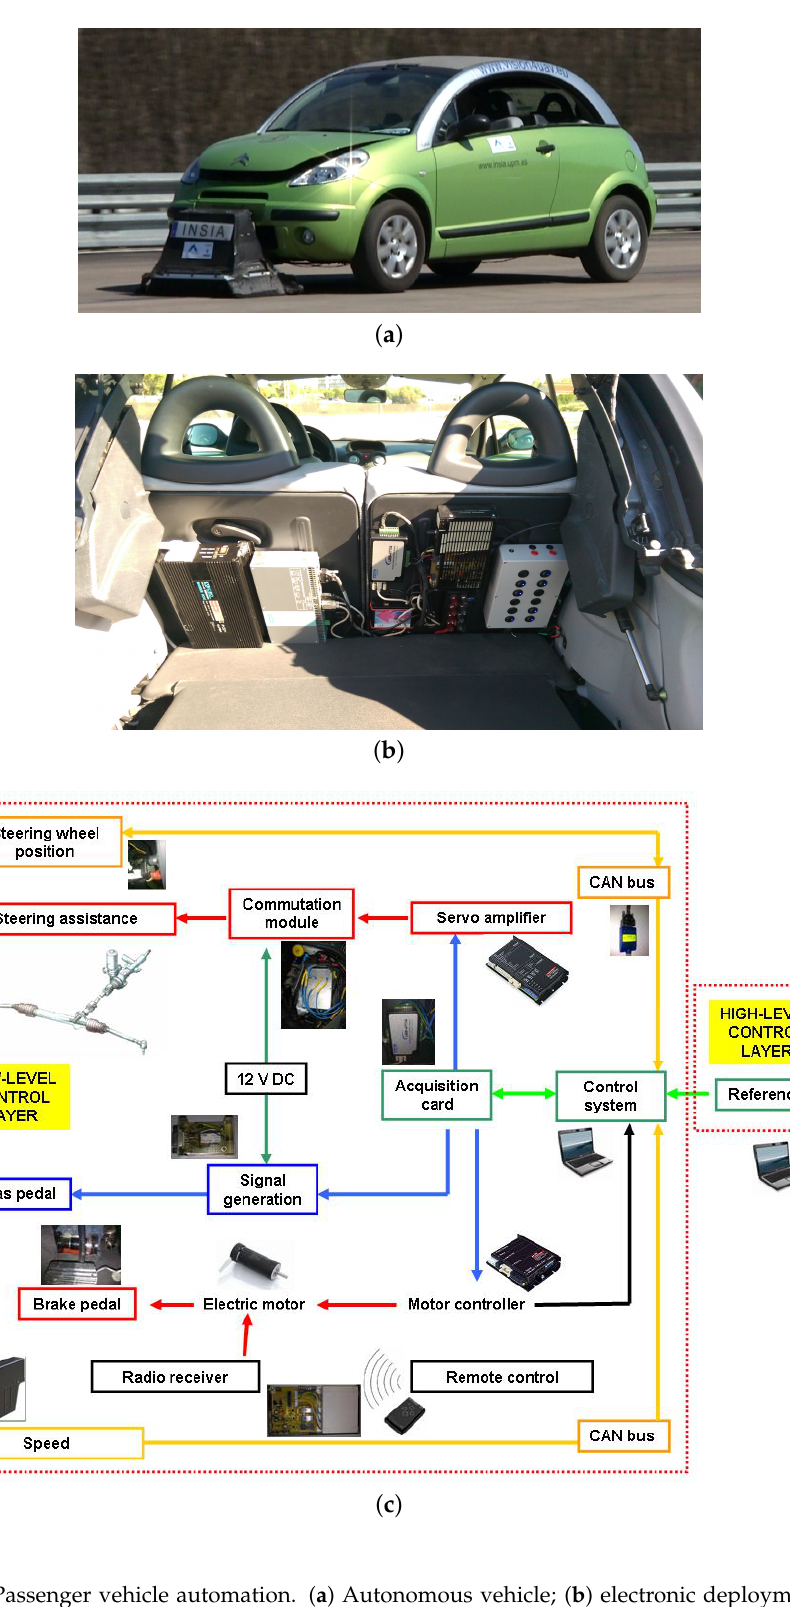
Figure 2. Passenger vehicle automation. ( a ) Autonomous vehicle; ( b ) electronic deployment of the control system; ( c ) internal architecture for vehicle